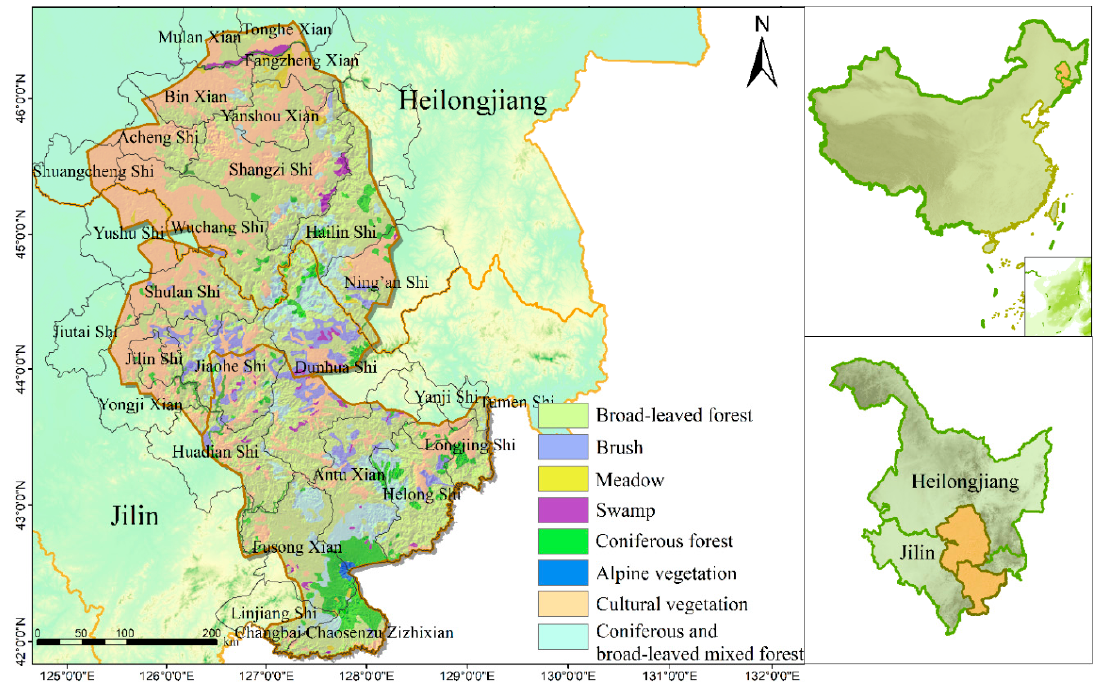
Figure 1. Location of the study area in Northeast China.